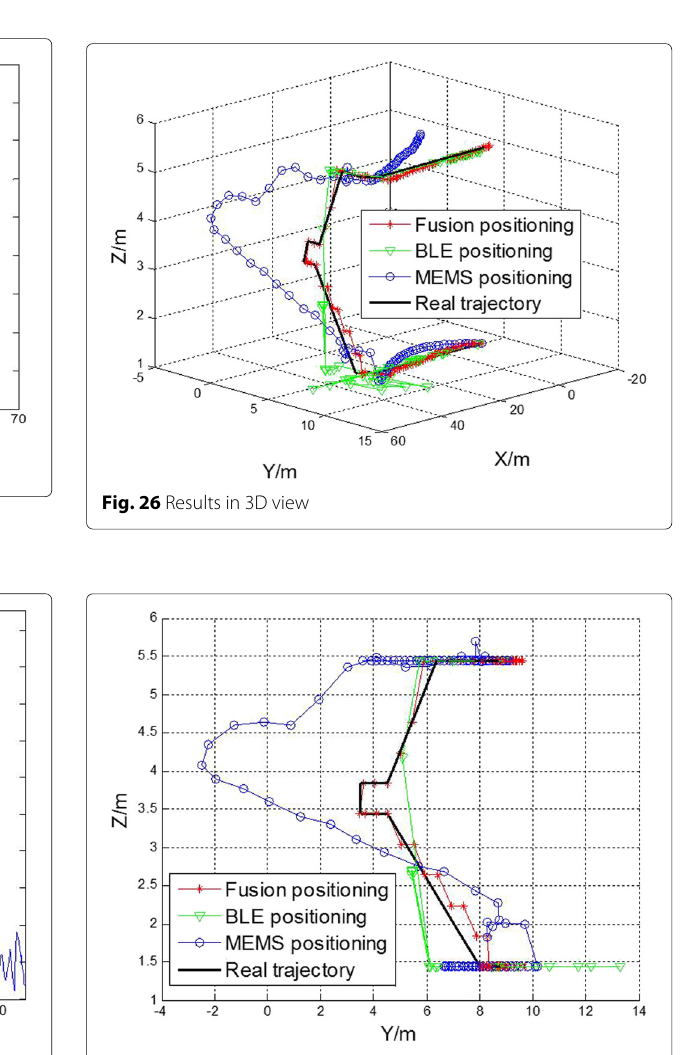
Fig. 24 Error variation of fusion positioning